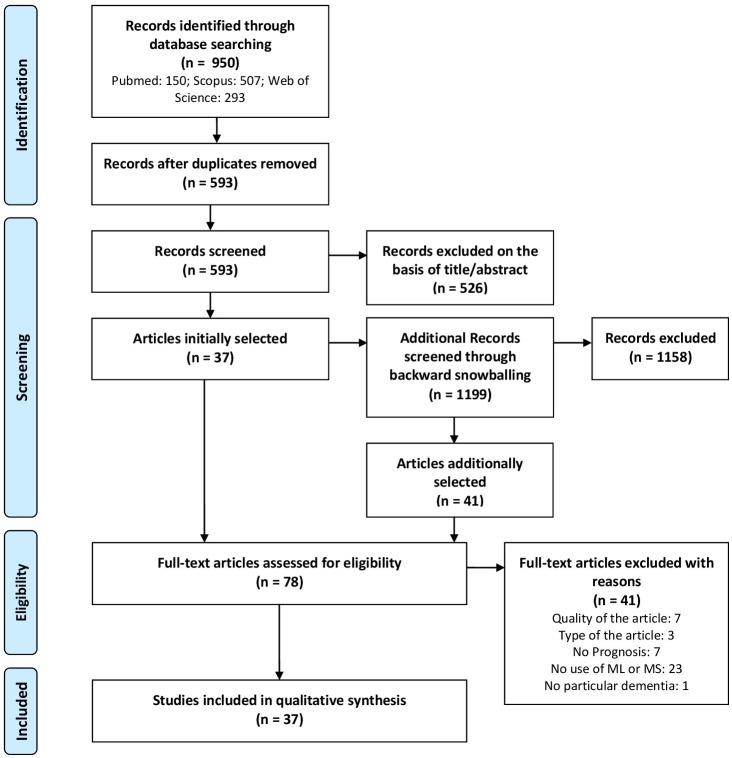
PRISMA flow chart.